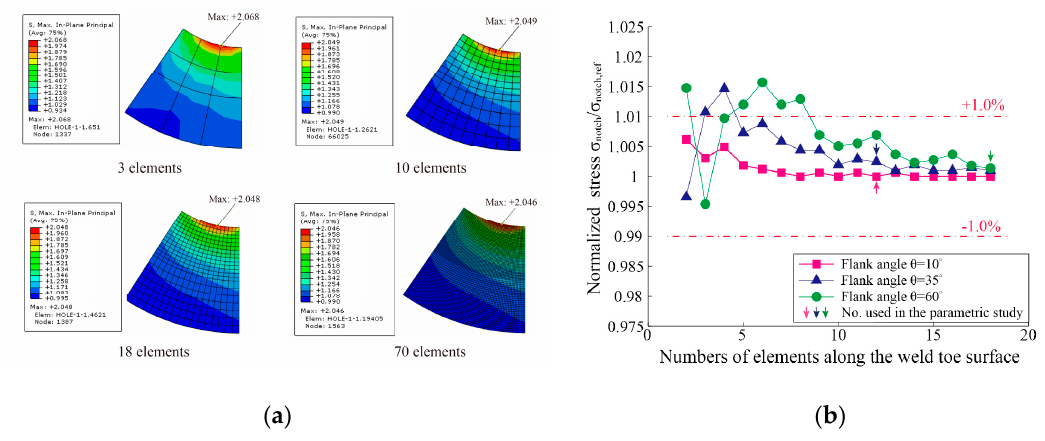
Figure 4. Convergence analysis of the mesh: ( a ) the first principal stresses under different numbers of elements: flank angle 35 θ= ; ( b ) normalized stresses under different numbers of elements.